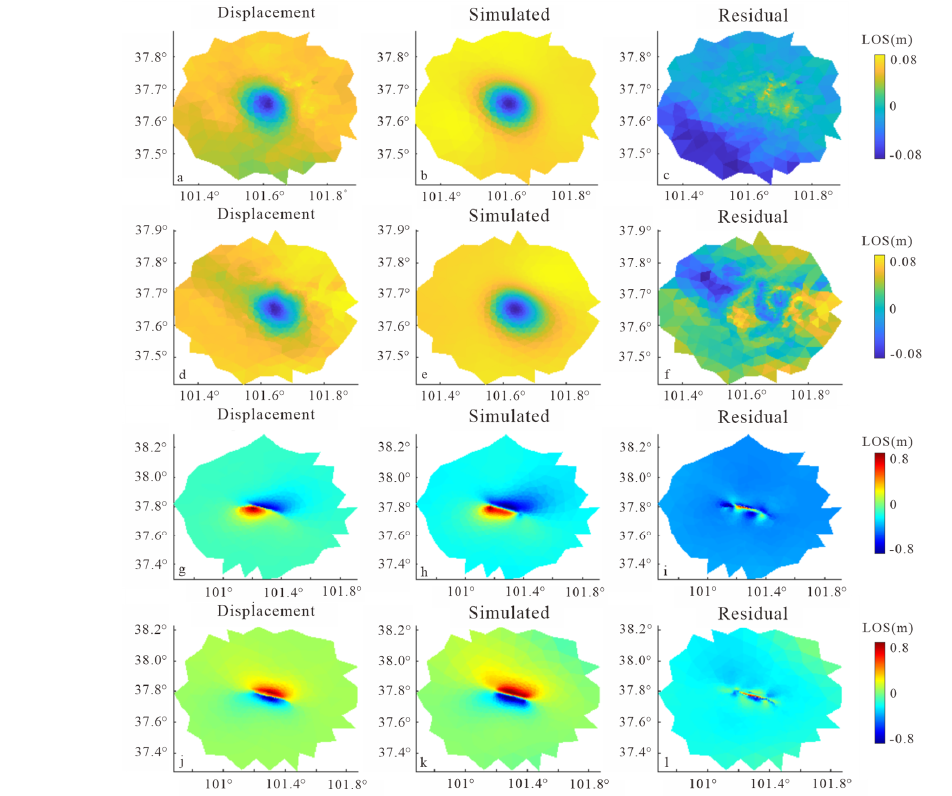
Figure 5. Distributed slip model of ( a ) the 2016 Menyuan earthquake and ( b ) the 2022 Menyuan earthquake.